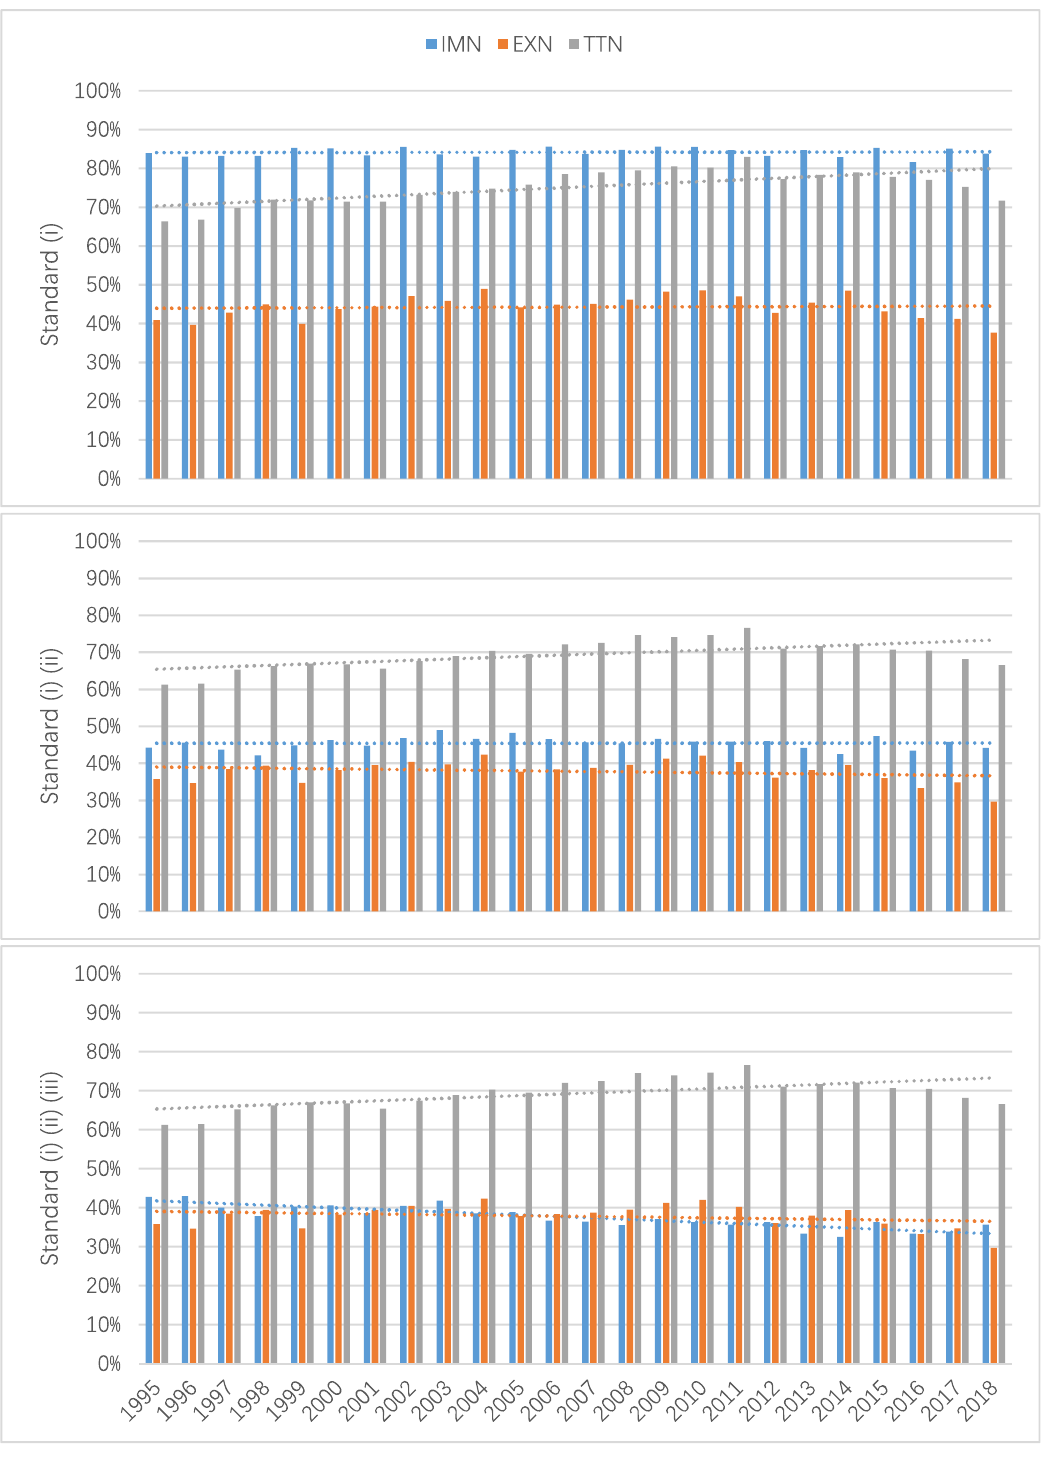
Figure 1. Proportion of products that meet the Standard level of scale-free in IMN (blue), EXN (orange) and TTN